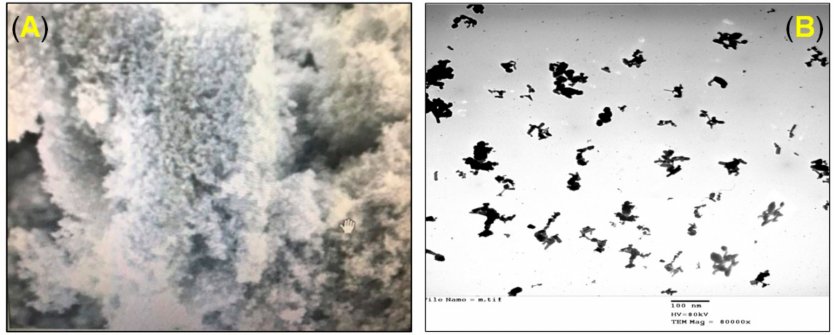
Figure 1. Scanning (SEM) ( A ), and transmission electron micrographs (TEM) ( B ) of synthesized zinc oxide nanoparticles (ZnO-NPs); 1–100 nm, HV = 80 kV, and TEM Mag = 8000 ×